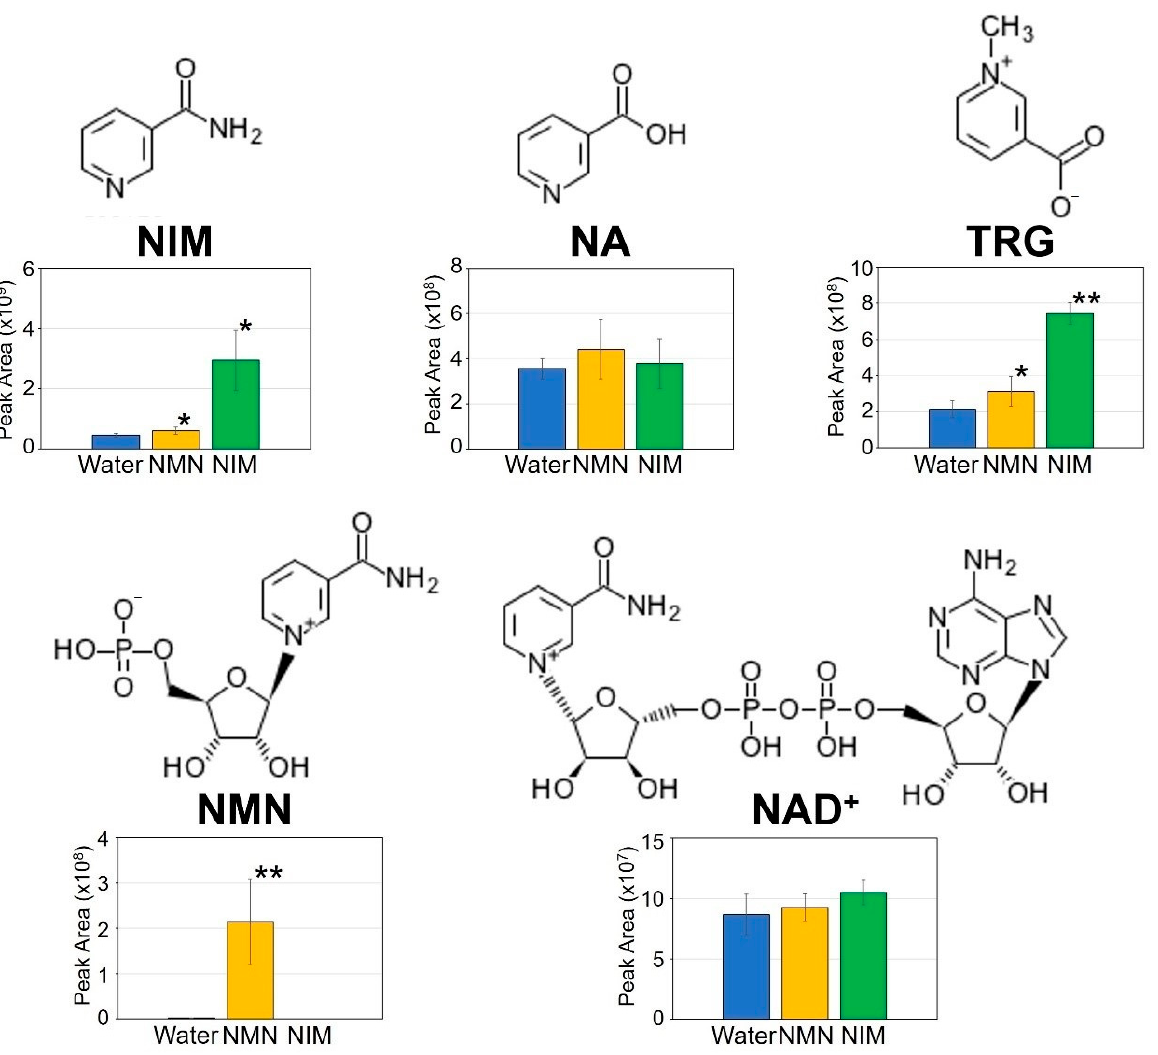
Figure 3. Effects of nicotinamide mononucleotide (NMN) and nicotinamide (NIM) pretreatment on pyridine metabolites in the wheat inoculated spikes. Relative amounts of metabolites NMN, NIM, nicotinic acid (NA), trigonelline (TRG), and nicotinamide adenine dinucleotide (NAD + ) were measured in water-, NMN-, and NIM-pretreated spikes based on the peak area of their precursor ions. Each bar represents standard deviation. Student’s t -test: * p < 0.05, ** p < 0.01, n = 4–5.